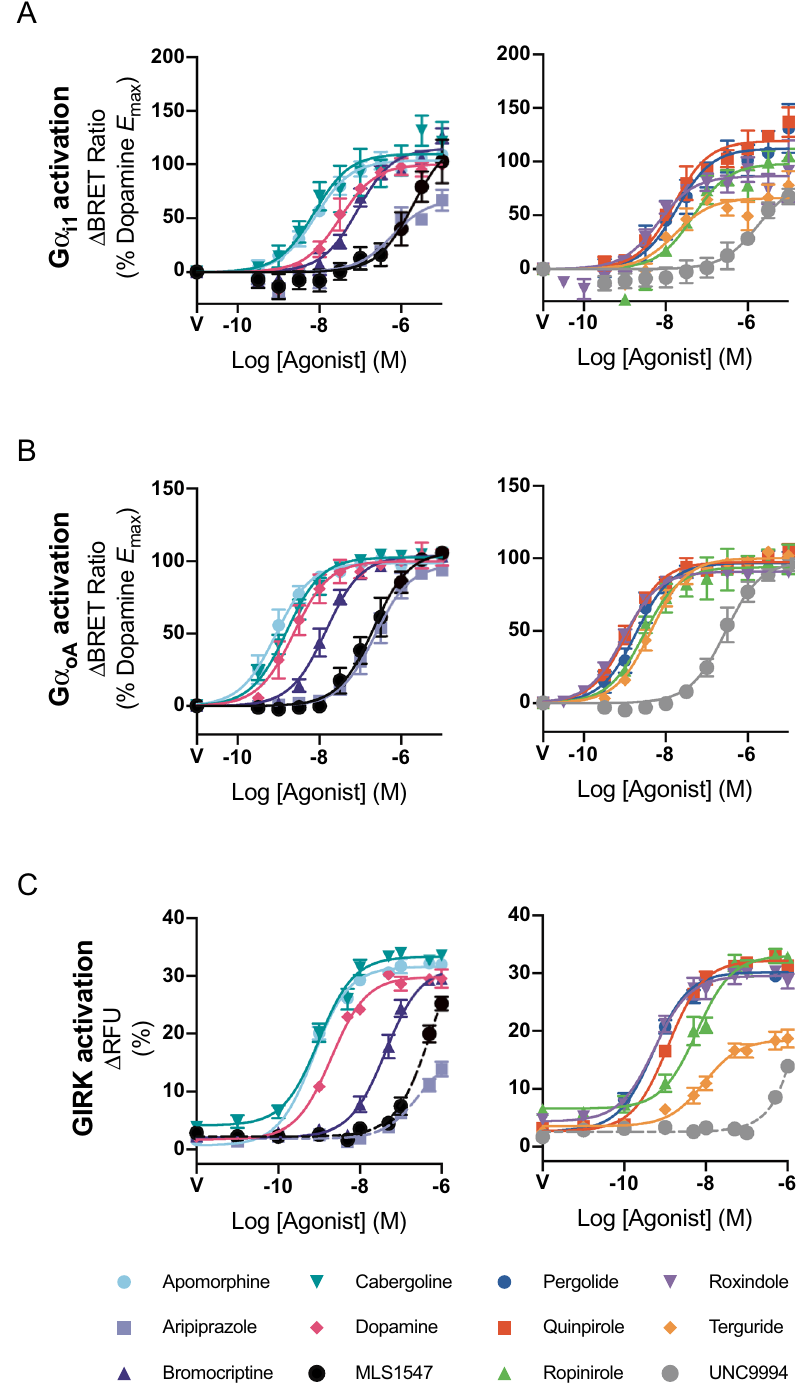
Figure 5. D 2 R mediated activation of Gα i1 , Gα oA and GIRK channels by distinct agonists. FlpIn™ HEK293 cells stably expressing hD 2L R were transfected with BRET sensors for ( A ) Gα oA activation and for ( B ) Gα i1 activation as described in Methods. Agonist responses were determined after 10 min at 37 °C. The response is plotted as the increase in BRET ratio normalized to the vehicle control (0%) and the maximal response produced by dopamine defined as 100%. ( C ) GIRK channel activation using a membrane potential kit. Data represents mean ± SEM of at least 5 experiments performed in